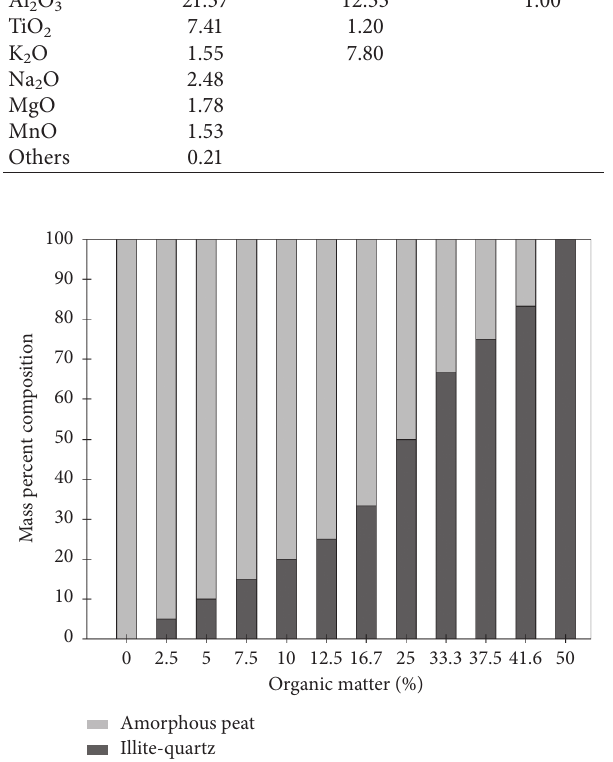
Figure 3: Proportion of samples with different organic matter content.